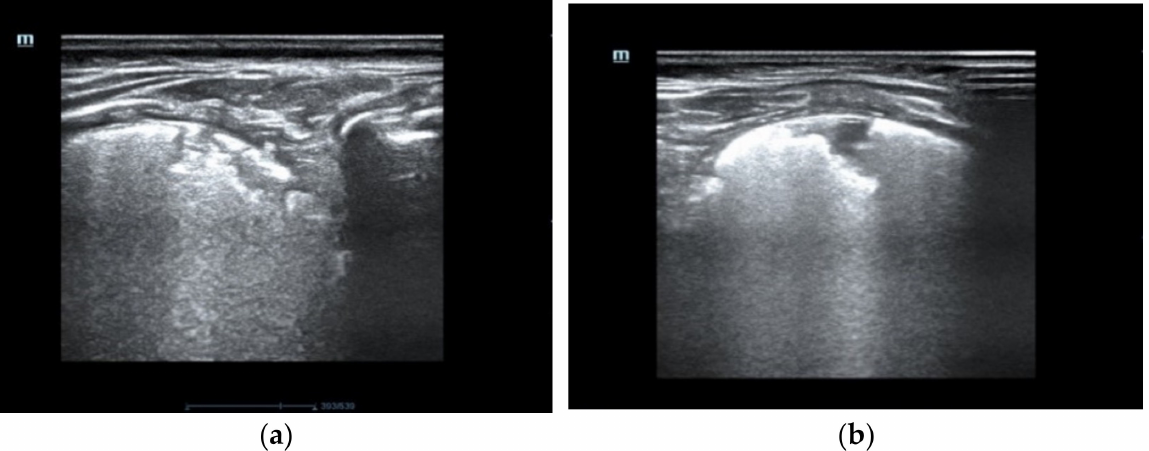
Figure 1. The pulmonary ultrasound shows compact B artifacts creating the image of white lungs with many subpleural consolidations. ( a ) posterior part of the right lung ( b ) the rear part of the left lung.